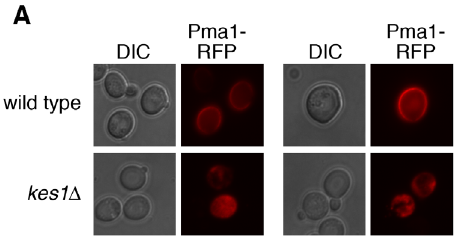
Figure 4. Kes1 regulates Pma1 localization. SEY6210- PMA1 -dsRFP (wild type) and SEY6210- PMA1 -dsRFP kes1 D (CMY306) cells were grown to mid-logarithmic phase in SC medium at 25 u C and visualized using a RFP filter. For quantification, 150 and 120 cells were counted for wild type and kes1 D cells, respectively, over three different experiments to determine the percentage of cells with Pma1-RFP intracellular accumulation (6% for wild type and 81% for kes1 D ). Representative images are